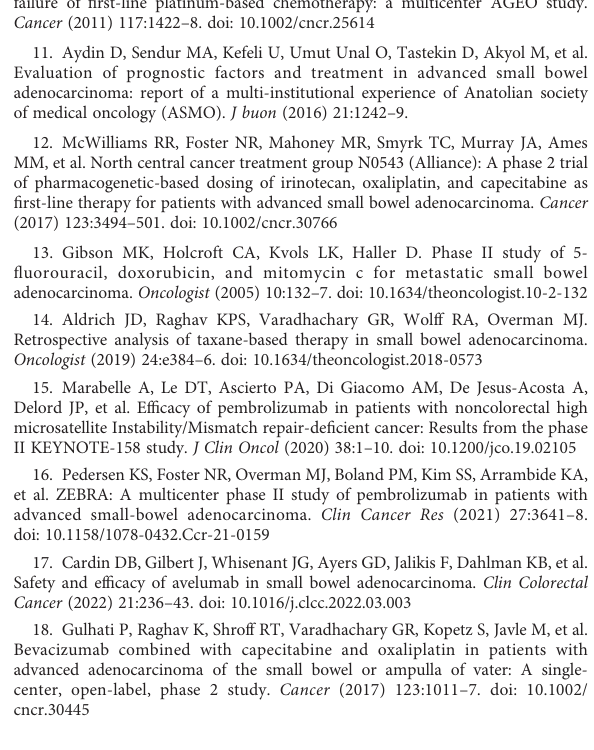
Computed tomography after six (A, B) , 11 (C, D) and 15 (E, F) sessions of tislelizumab in combination with